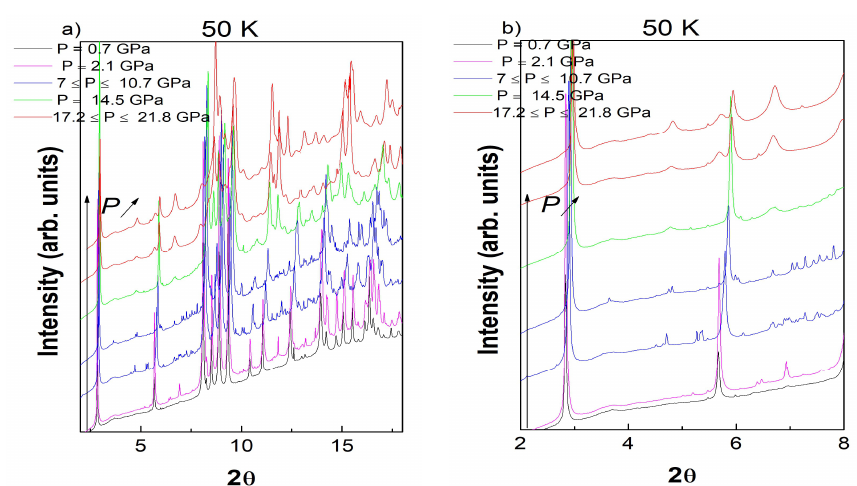
Figure 6. Pressure dependence of the LuFe 2 O 4 X-ray data at 50 K, ( a ) full-2 θ -range, ( b ) 2 ◦ –8 ◦ -2 θ -range.